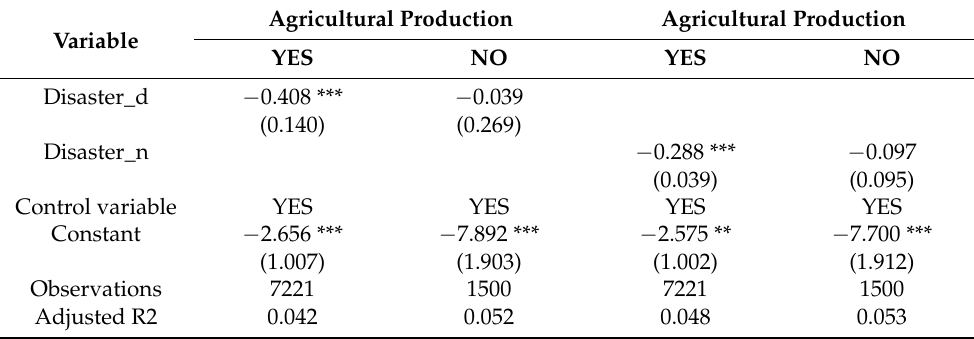
Table 8. Heterogeneous effects of natural disaster by agricultural production status.